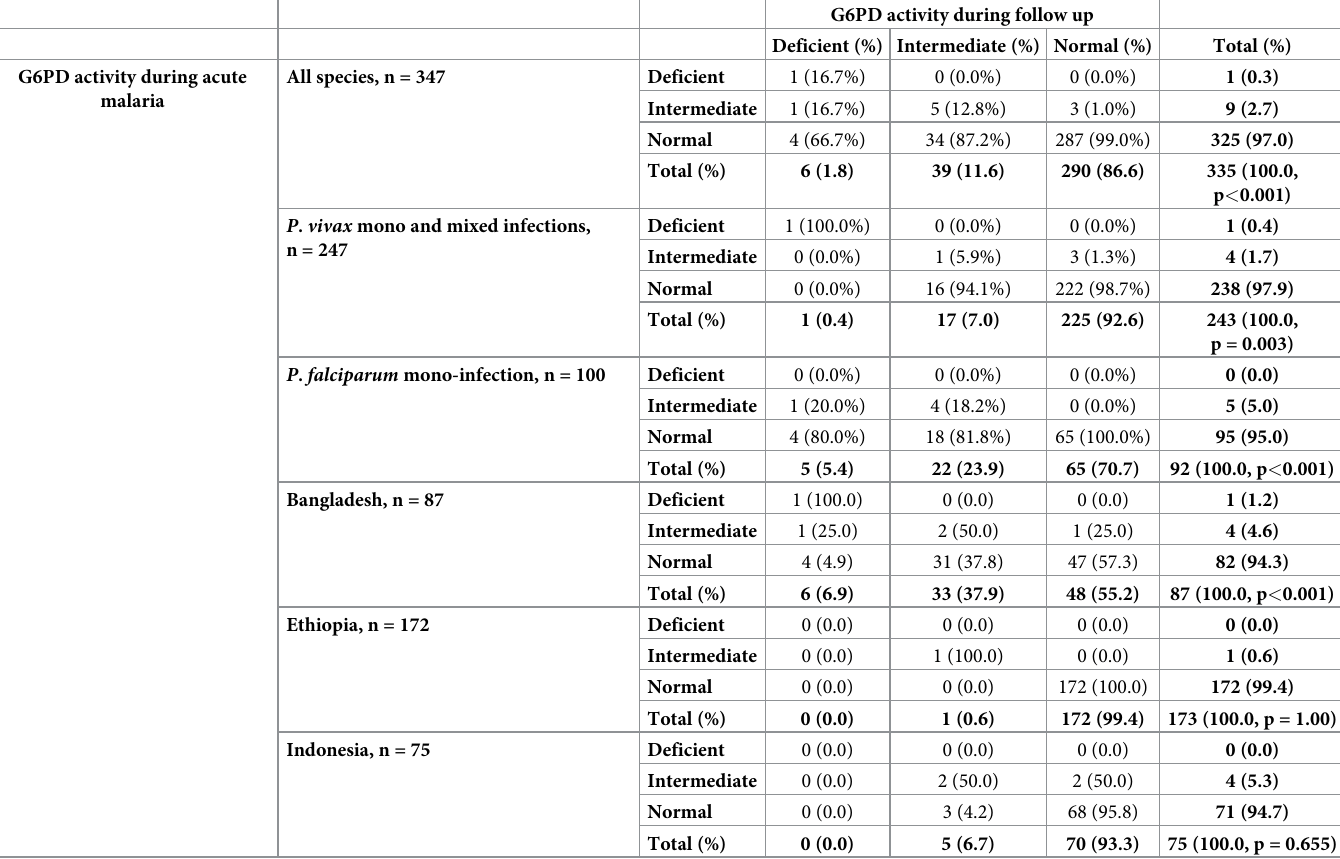
Table 3. Participants categorized by G6PD status during acute malaria and follow up stratified by species and